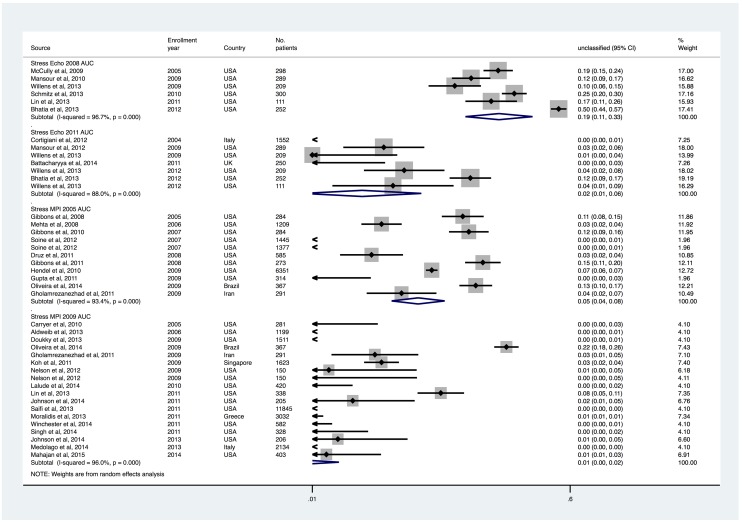
Unclassified Use Rates of Stress Echocardiography and MPI, Sorted by Patient Enrollment Year.